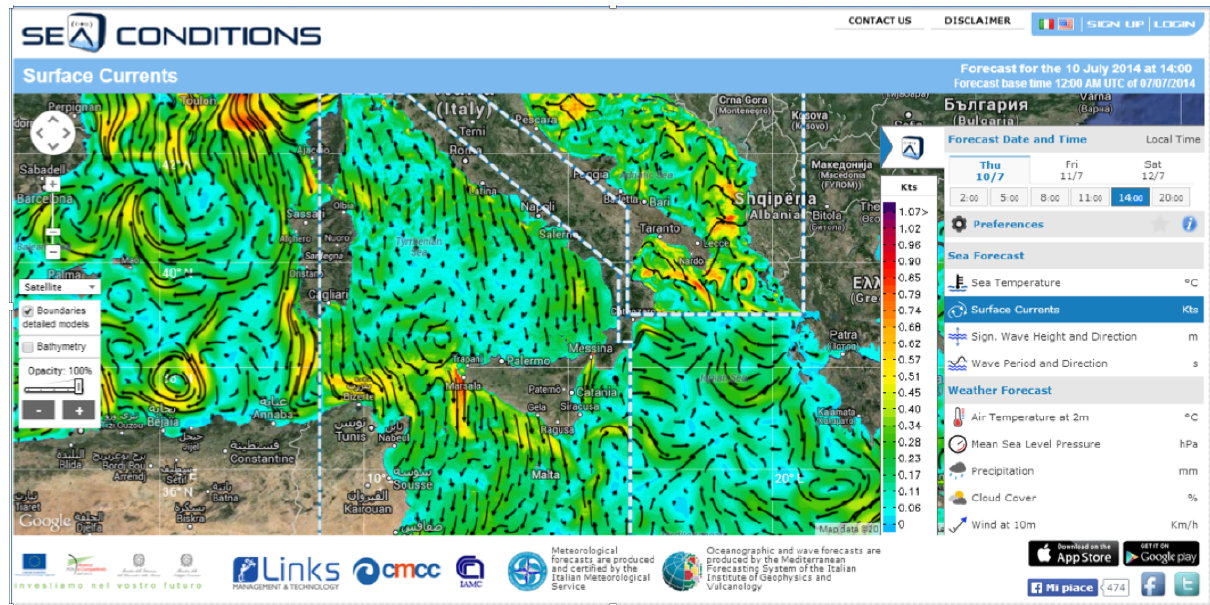
Figure 5. SeaConditions web application – example of surface sea current map and (inset) time series of its intensity and direction variability in relation to the region highlighted with a red circle.